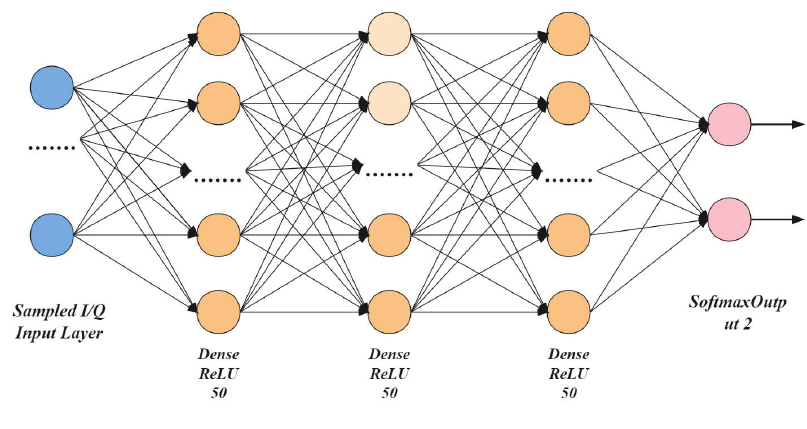
Figure 7. The architecture of the DNN network for classifying legitimate/illegitimate